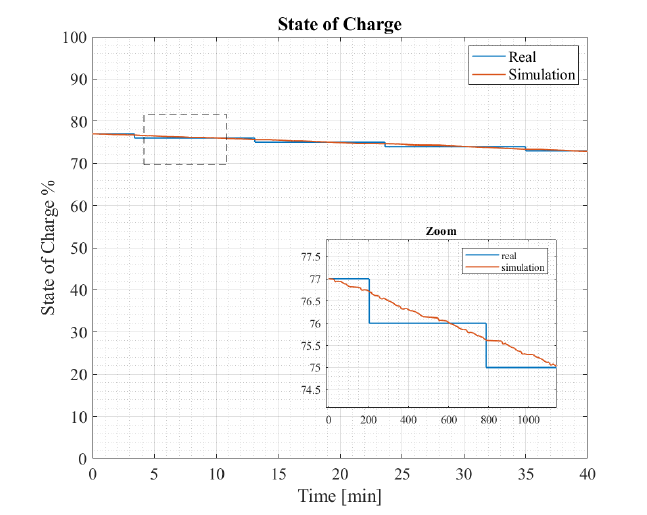
Figure 16. Comparison of the state of charge value obtained from the model and that achieved during the experimental tests.